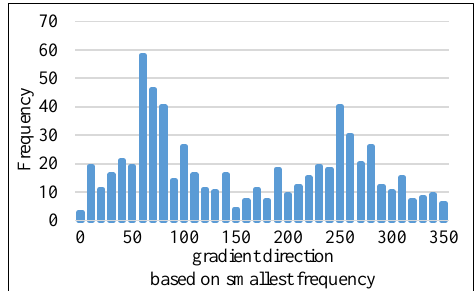
Figure 6. Histogram of gradient directions based on the smallest frequency from blurry images